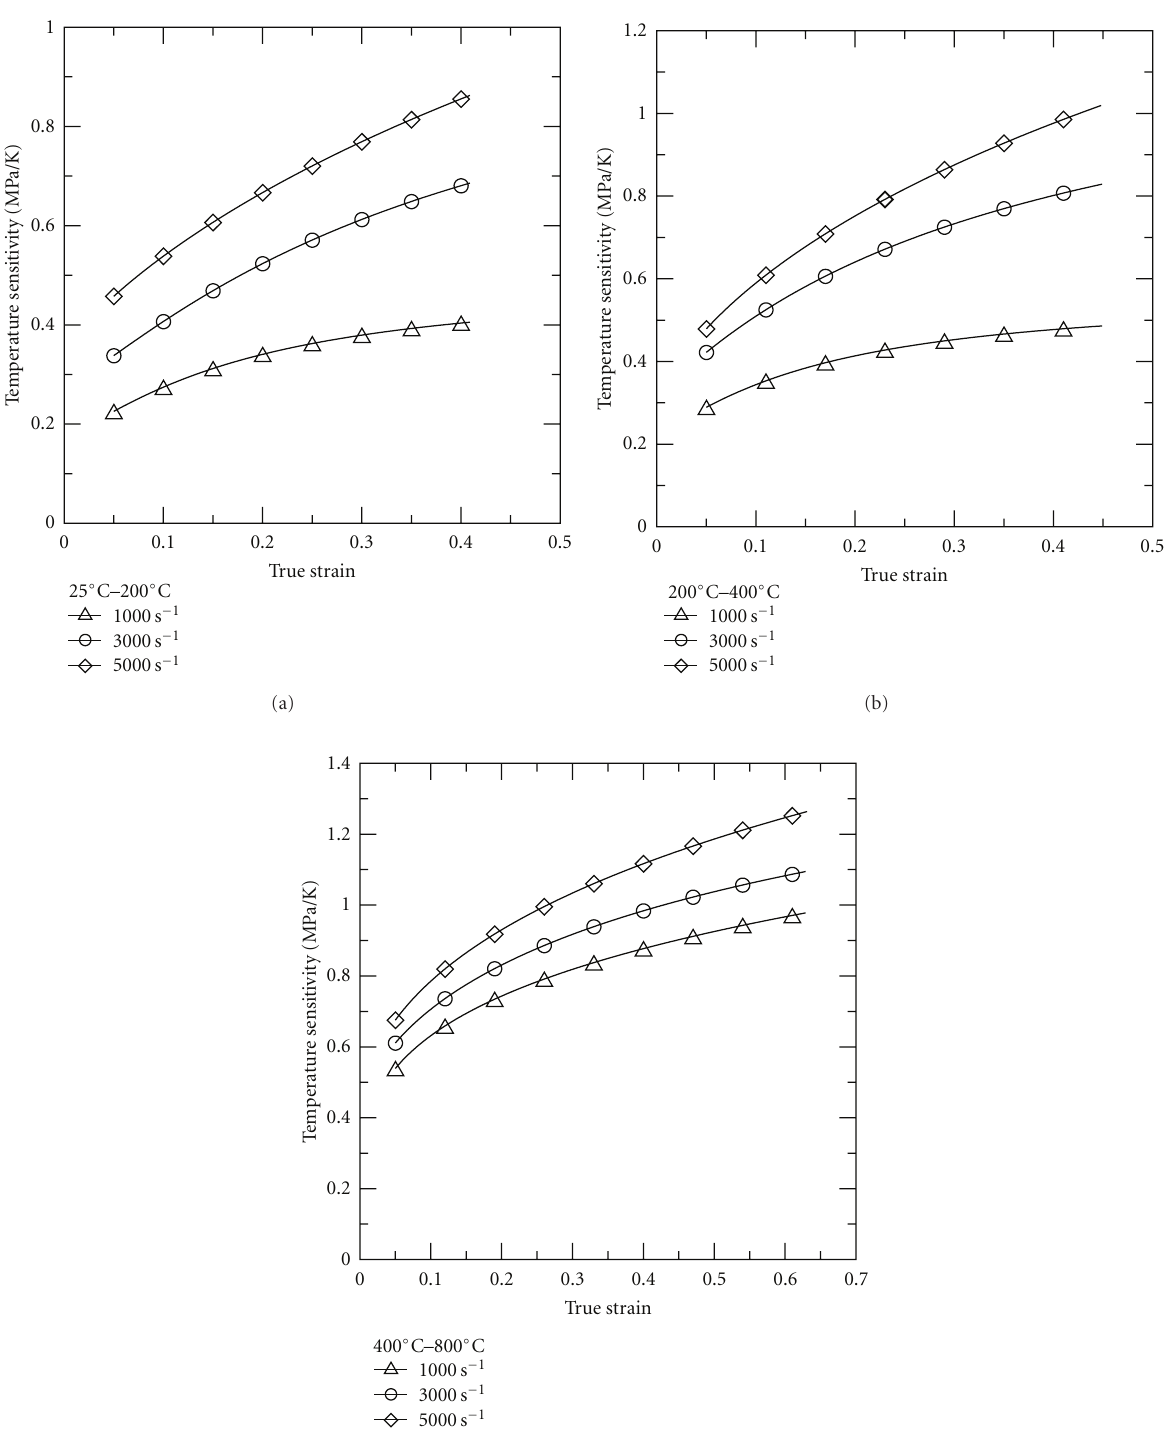
Figure 7: Temperature sensitivity of 316L stainless steel at temperatures in the range of (a) 25 ◦ C to 200 ◦ C; (b) 200 ◦ C to 400 ◦ C; (c) 400 ◦ C to 800 ◦